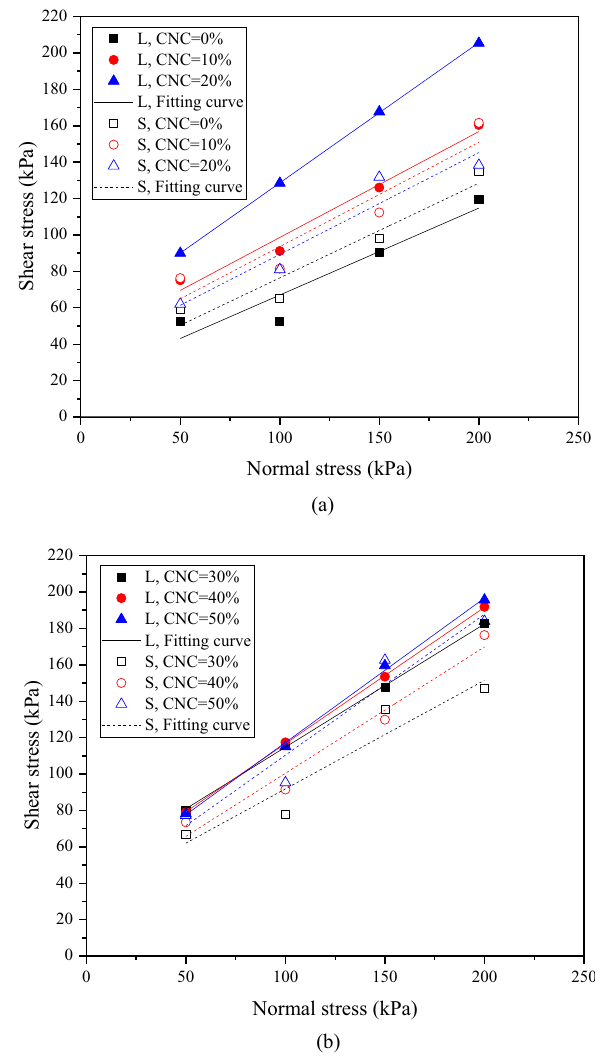
Figure 5. Shear stress versus normal stress plot of CSCN samples with large size and corresponding scaling size at the CNC of ( a ) 0%–20% and ( b ) 30%–50%.